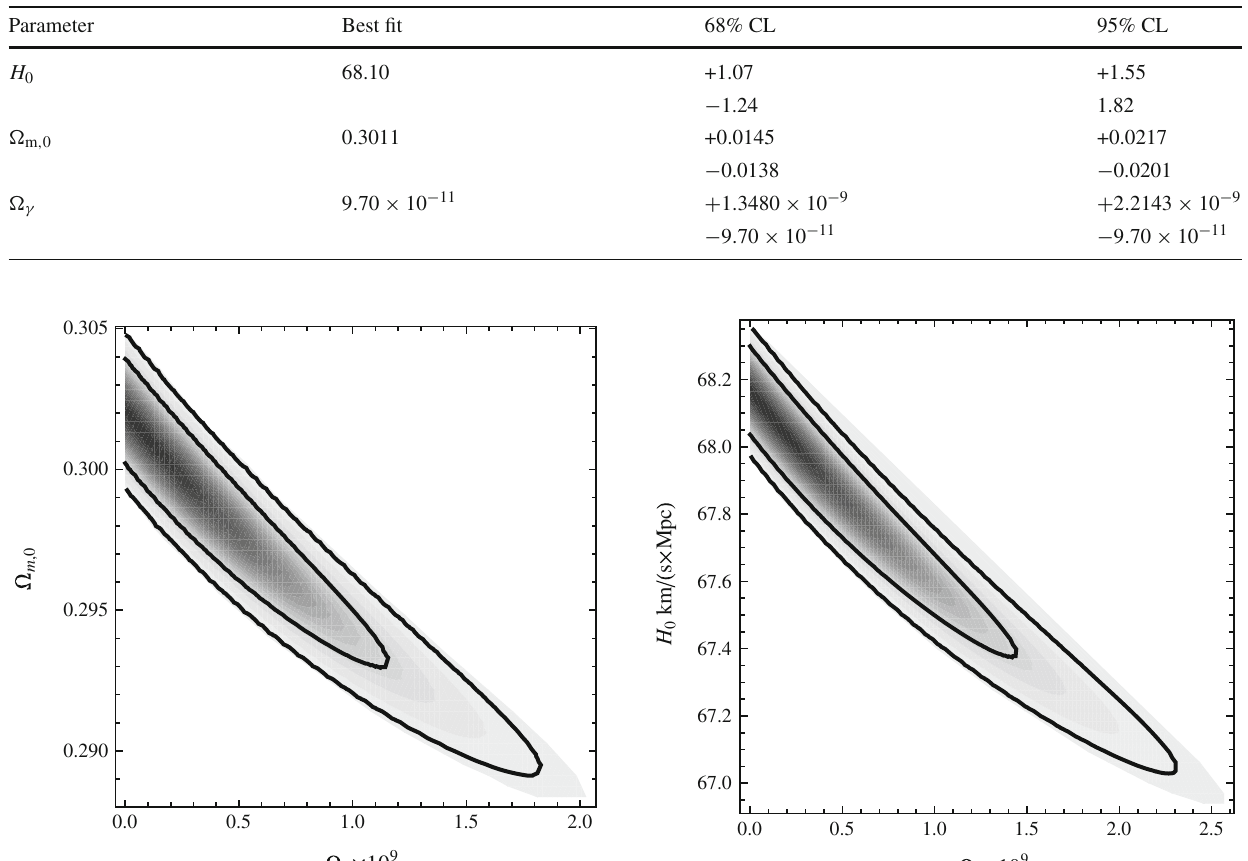
Table 1 The best fit and errors for the estimated model for the posi- radiation equality is assumed as 3395. H 0 , in the table, is expressed in km/(s Mpc). The value of reduced χ 2 of the best fit of our model is tive (cid:3) γ with (cid:3) m , 0 from the interval ( 0 . 27 , 0 . 33 ) , (cid:3) γ from the interval ( 0 . 0 , 2 . 6 × 10 − 9 ) and H 0 from the interval [66.0 (km/(s Mpc)), 70.0 (km/(s Mpc))]. (cid:3) b , 0 is assumed as 0.048468. The redshift of matter–